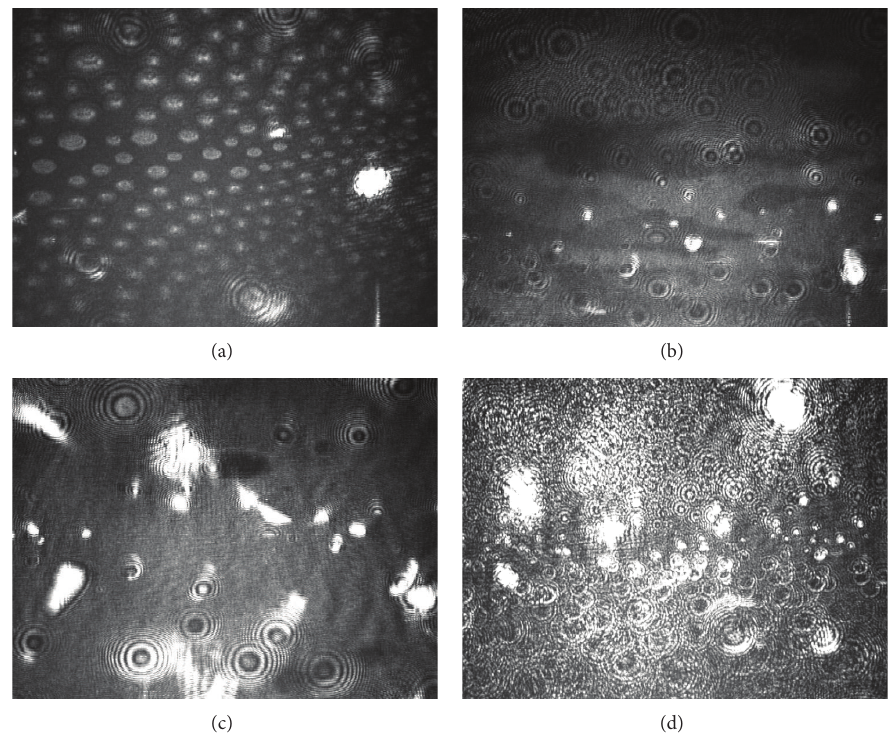
Figure 4: BAM images for PA-silica nanoparticles interfacial layers with different PA concentrations, namely, (a) 2 × 10 −5 M, (b) 5 × 10 −5 M, (c) 8 × 10 −5 M, and (d) 1 × 10 −4 M. Reprinted from [50]. Reproduced by permission of the PCCP Owner